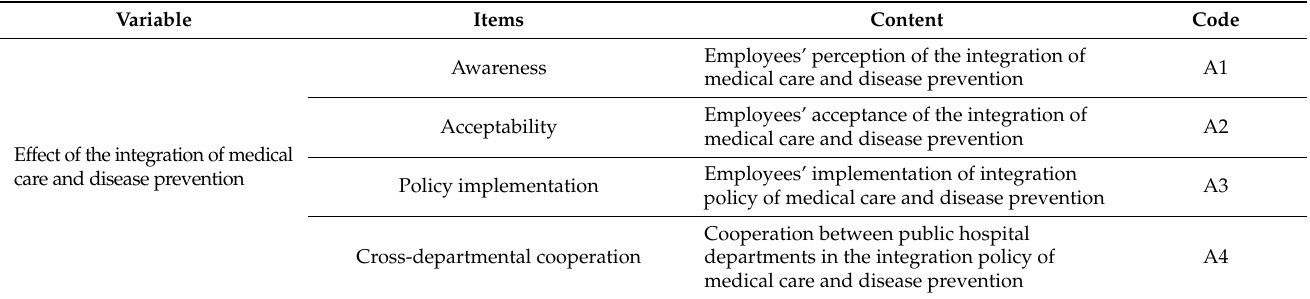
Table 2. Latent variable and